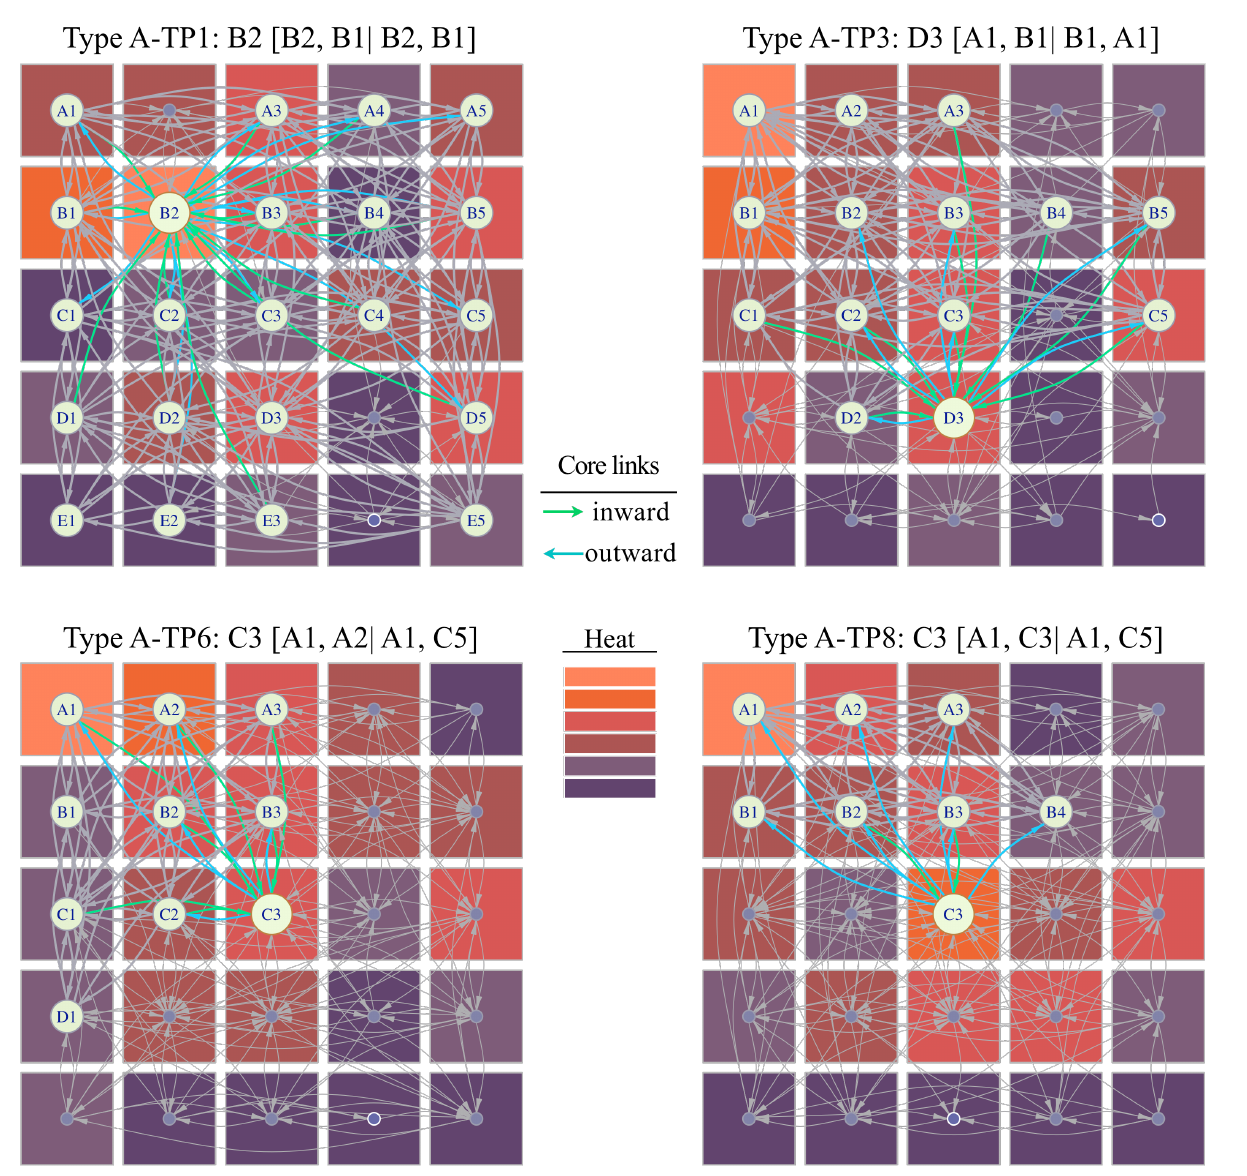
Figure 5. Networks and heat maps by TP of Type A with the clique communities highlighted by large and brightly colored nodes with Type-TP labels accompanied by the core node and the primary and secondary hot segments measured by NFix and NLop, i.e., [ NFix 1st , N Fix 2nd | NLop 1st , NLop 2nd ]. [Note] Segments are colored by heat grade listed in Table 2 .